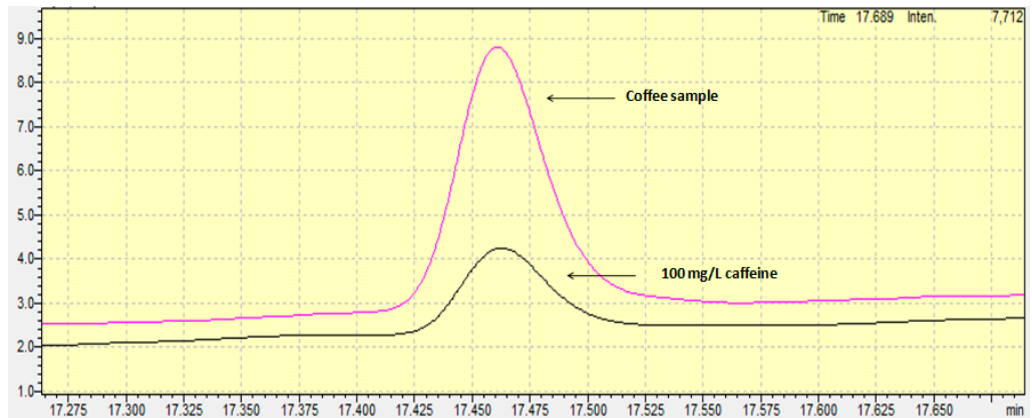
Figure 1. Chromatograms of caffeine in a standard solution and in a coffee grain sample.